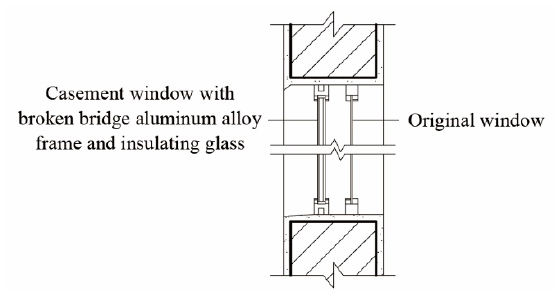
Figure 33. Adding a new window.